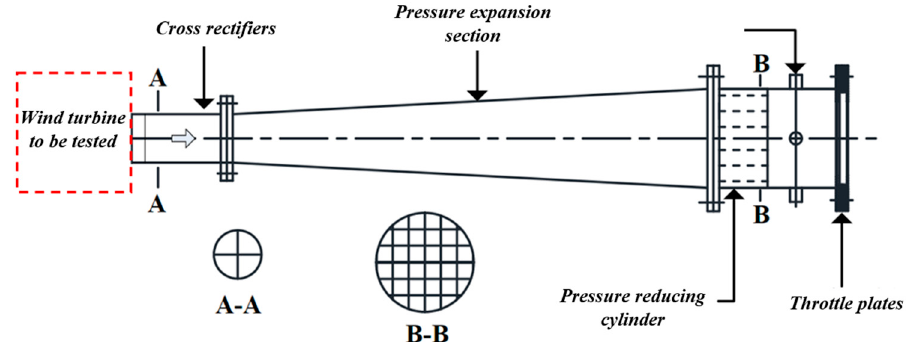
Figure 14. A schematic diagram of the ventilator performance test device.